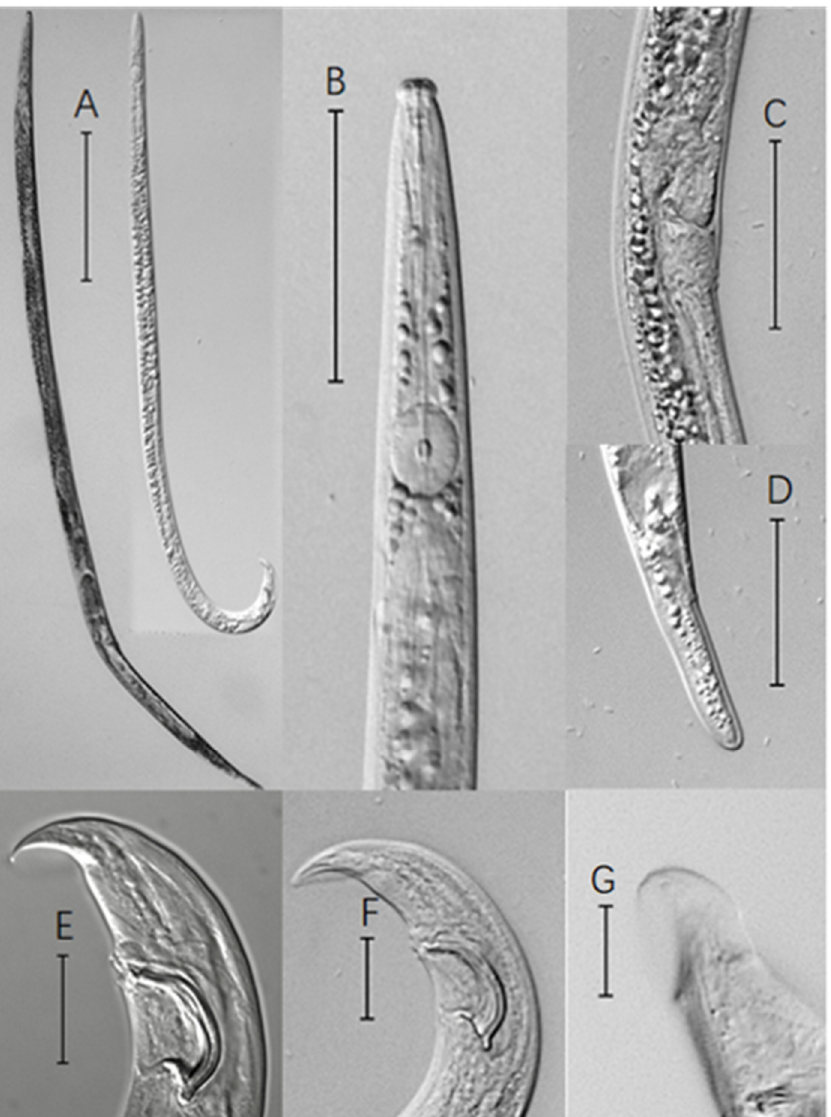
Figure 2. Photomicrographs of pine wood nematode (PWN). A: Entire view of female (left) and male (right); B: Anterior region of female; C: Vulva region; D: Female tail; E, F: Ventral view of male tail; G: Bursa of the adult male tail. (Scale bars: A = 200 μ m; B, C, D = 50 μ m; E, F, G = 20 μ m).